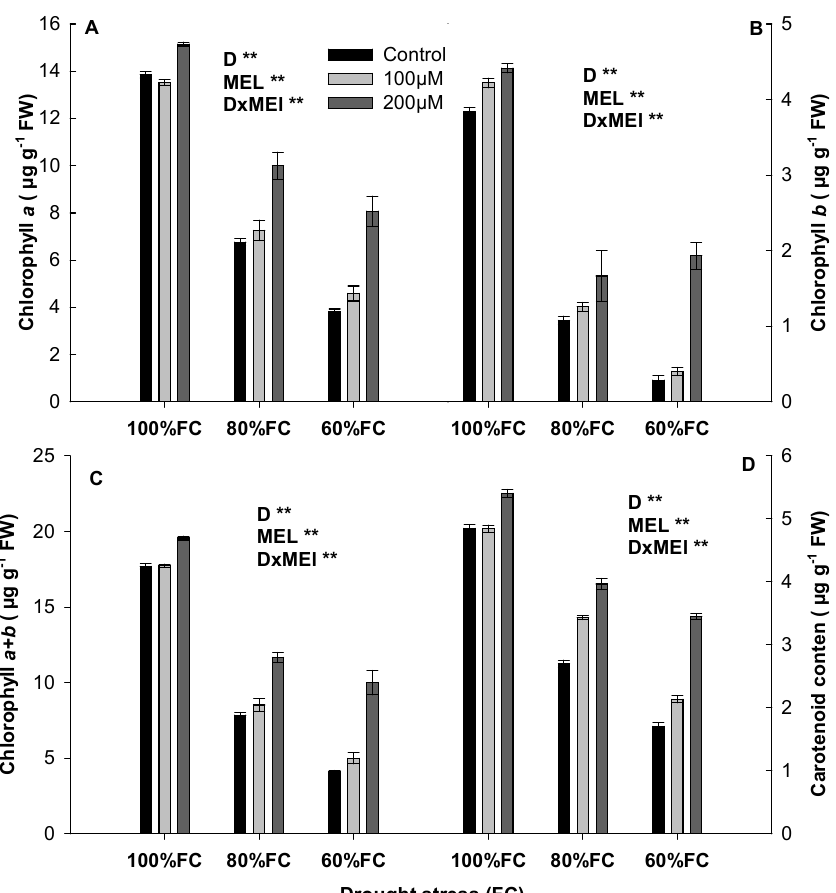
Figure 1. Changes in plant pigments, i.e., ( A ) Chl a ; ( B ) Chl b ; ( C ) Chl a + b ; and ( D ) carotenoid content as affected by root application of MEL under drought stress. 100% FC represents no stress, 80% FC represents mild stress, and 60% FC signifies severe stress. Error bars represent standard error of replicates. ** represents significant difference at 1% level of probability. D represents drought stress levels, while MEL represents MEL Levels, and DxMEL is the interaction between both factors.